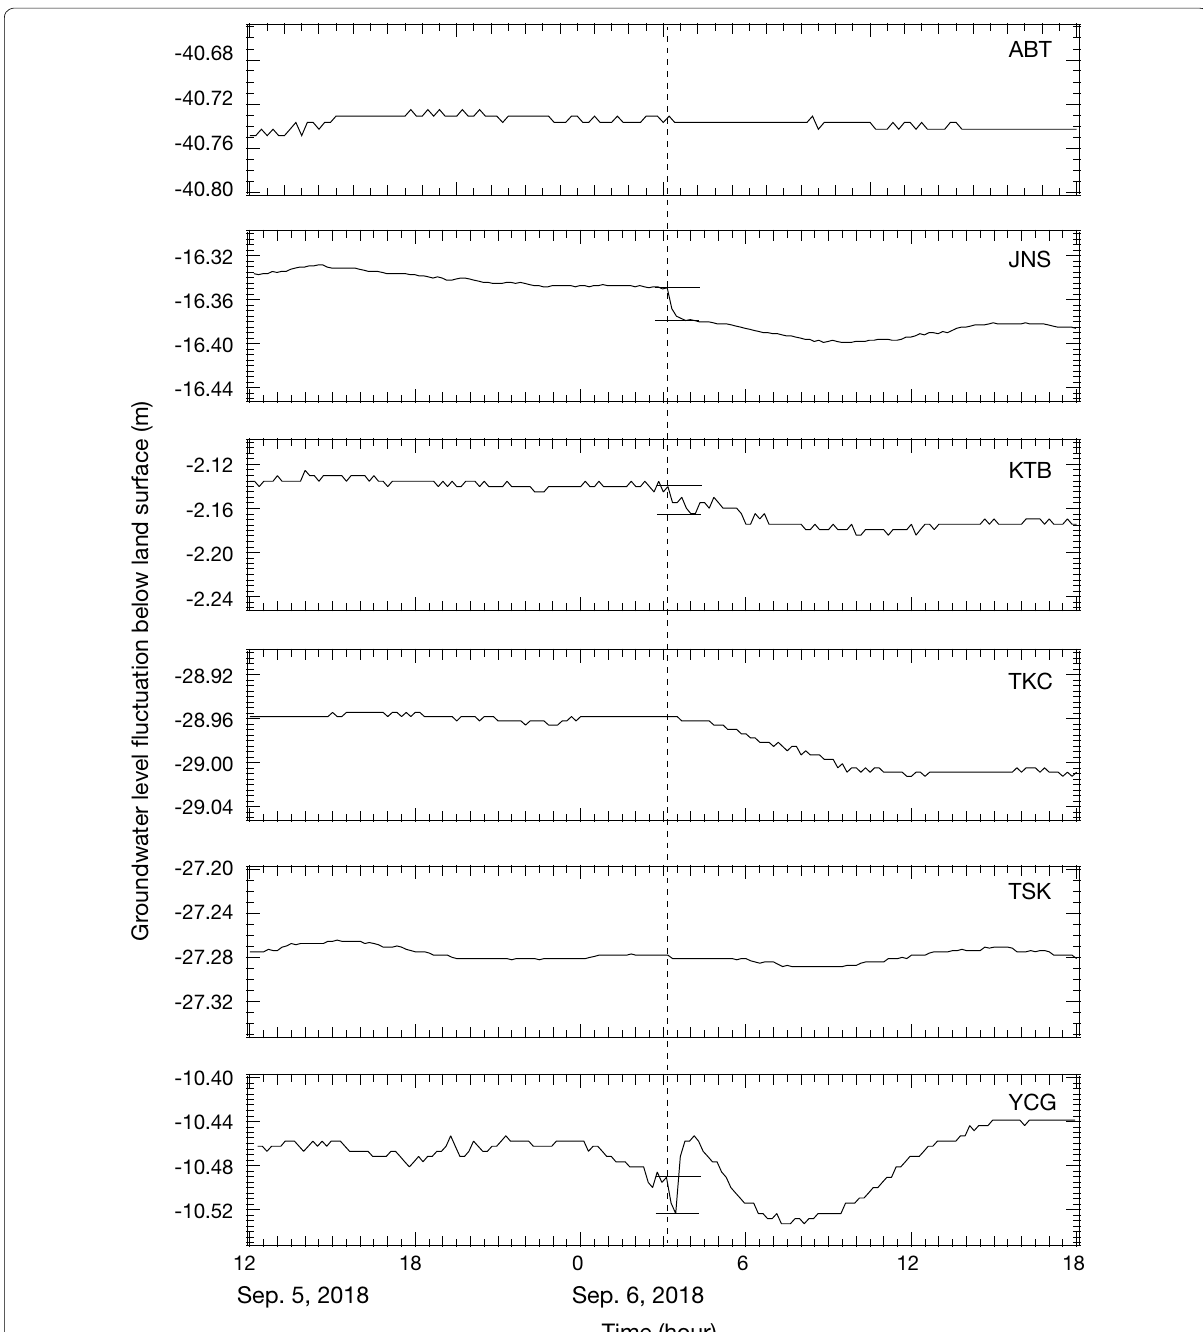
Fig. 3 Observed groundwater levels in the monitored observation wells at 10‑min intervals. The step‑like decreases, which are highlighted between two horizontal lines around the time of the earthquake, are detected in wells JNS, KTB, and YCG. The dotted line indicates the timing of the